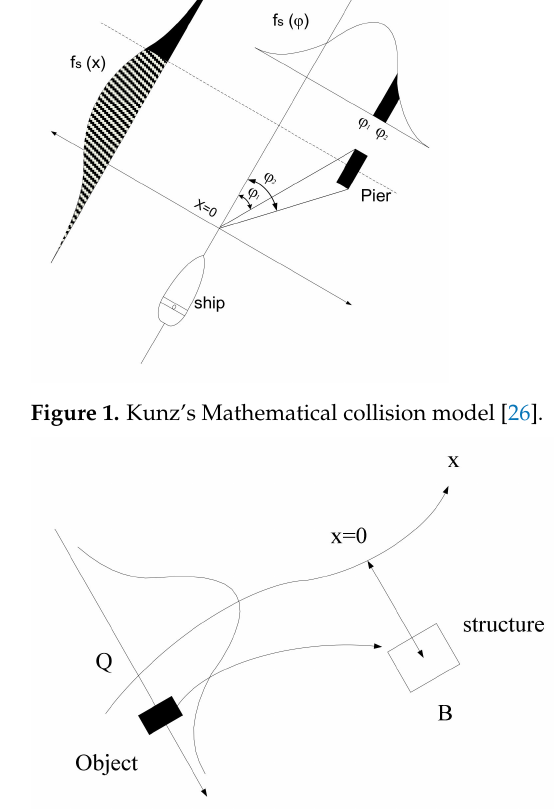
Figure 2. Illustration for probabilistic collision model in Eurocode (Based on